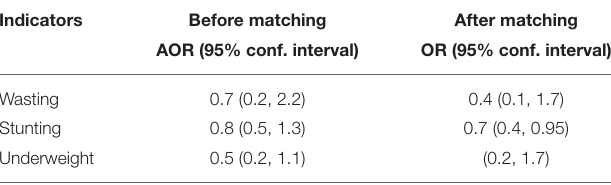
TABLE 6 | The effect of appropriate complementary feeding practices on child growth indicators for children aged 6–23 months in Malawi.